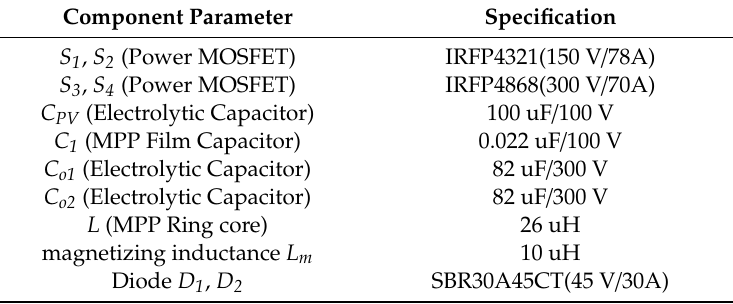
Table 4. Component